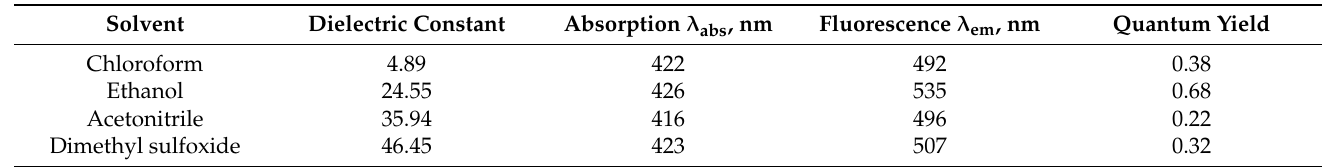
Table 1. Photophysical parameters of 3-(phenylethynyl)-7 H -benzo[ de ]anthracen-7-one in various solvents (at a concentration of 1 × 10 − 5 mol L − 1 ).